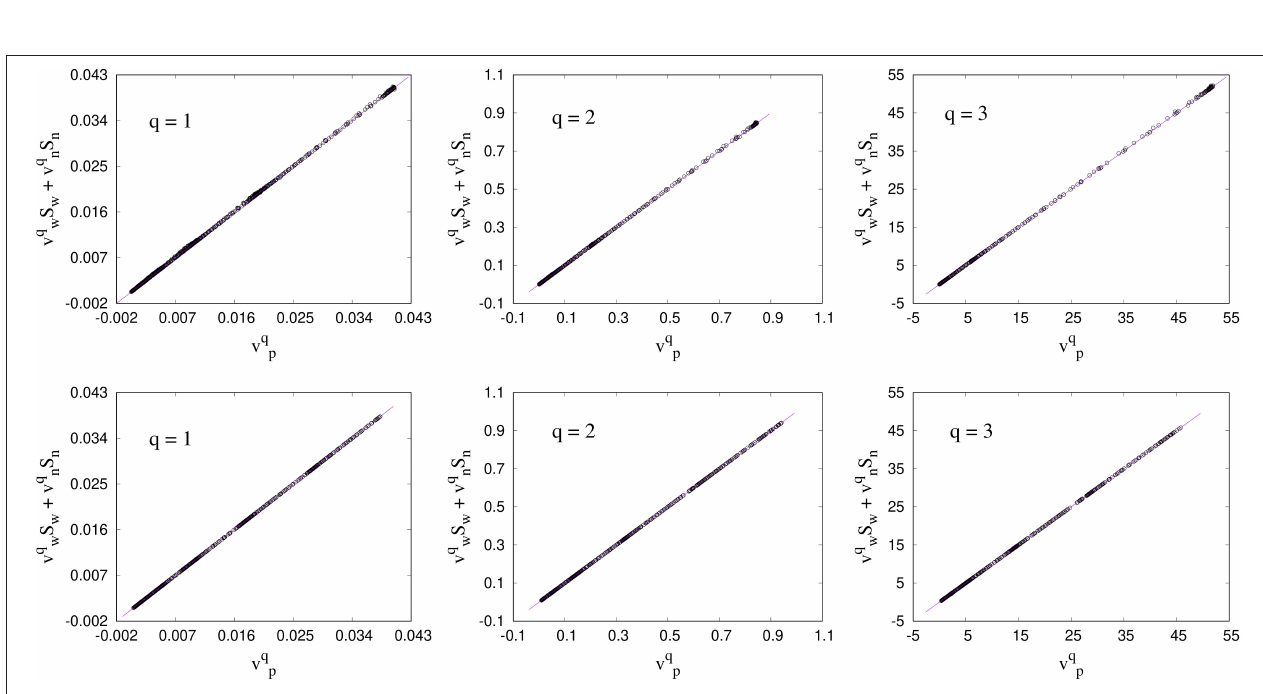
2 and 3, the units for v q p will be mm 2 /s and =